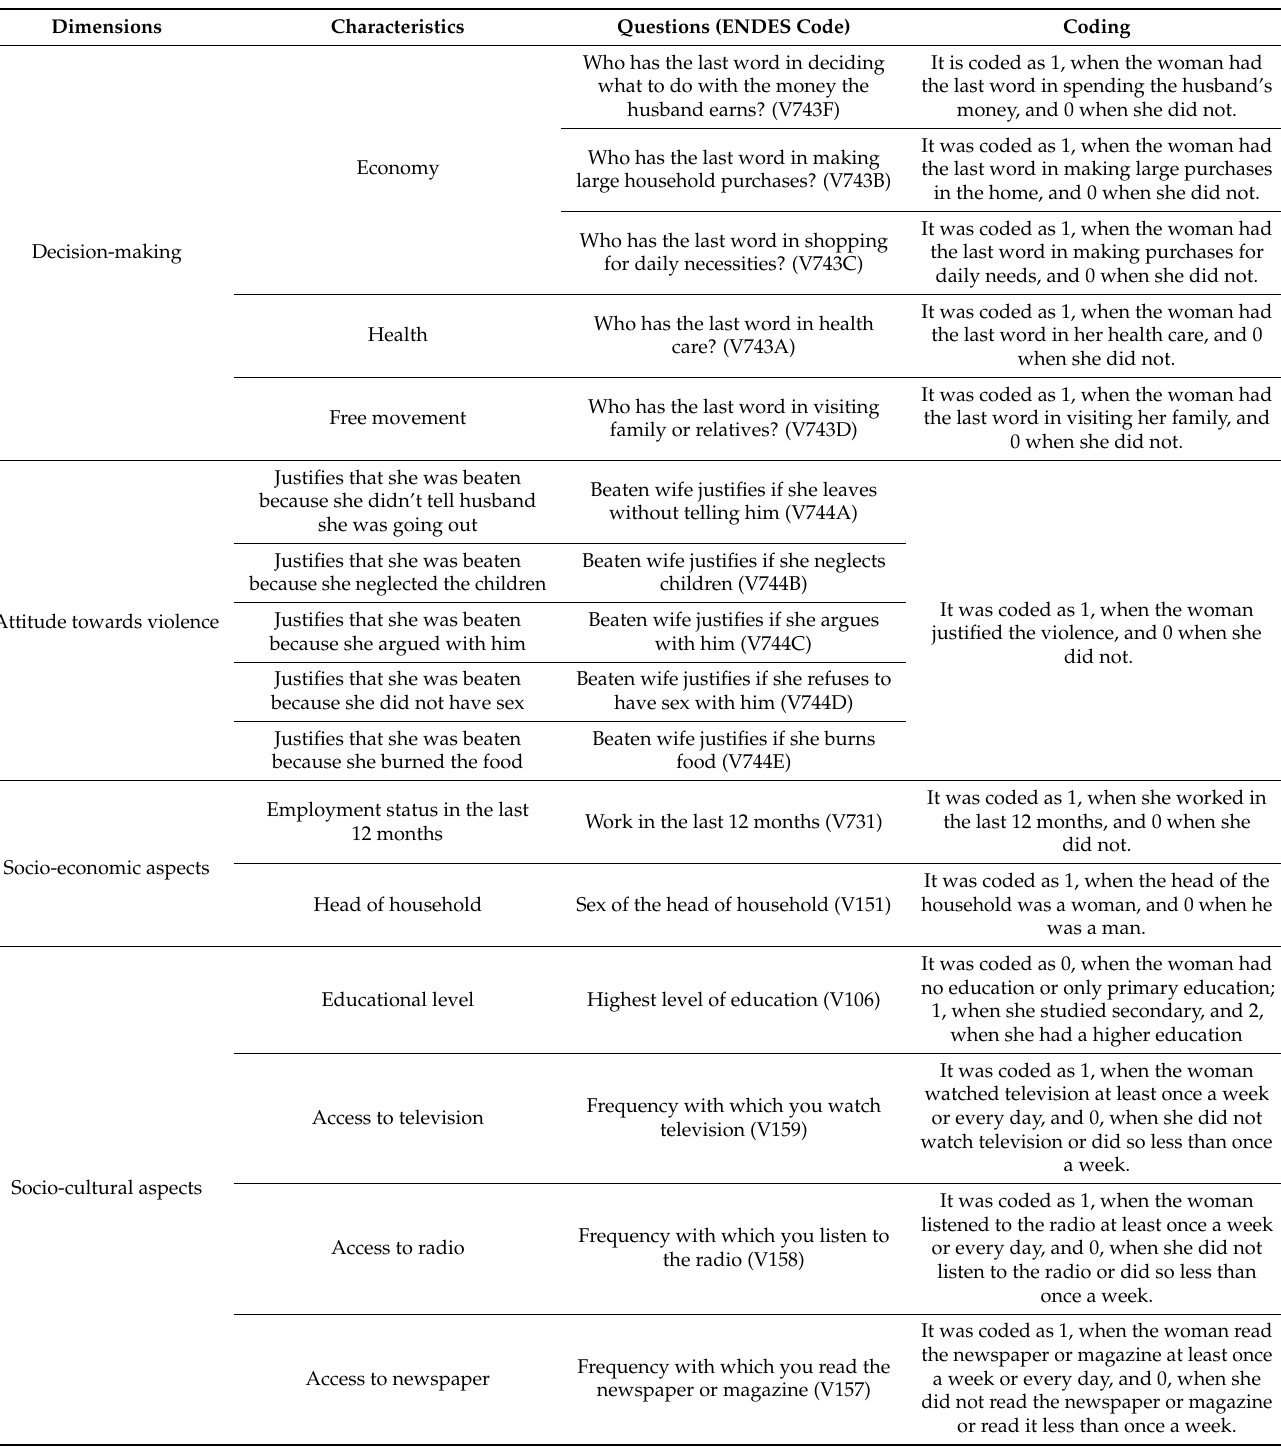
Table 1. Variables that make up the autonomy of